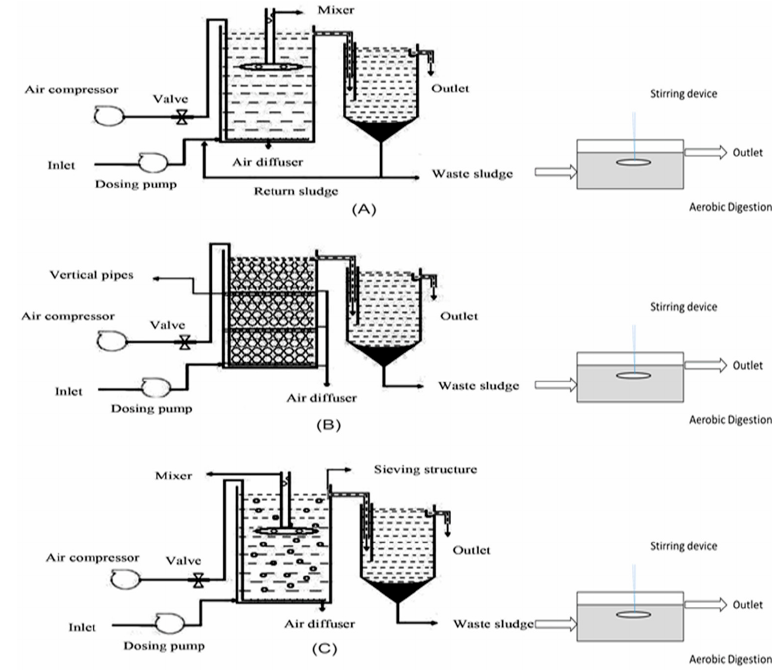
Figure 1. The schematic appearance of biological treatment process in the presence of an aerobic digester ( A ) ASP: Activated Sludge Process, ( B ) PBBR: Packed Bed Biofilm, ( C ) MBBR: Moving Bed